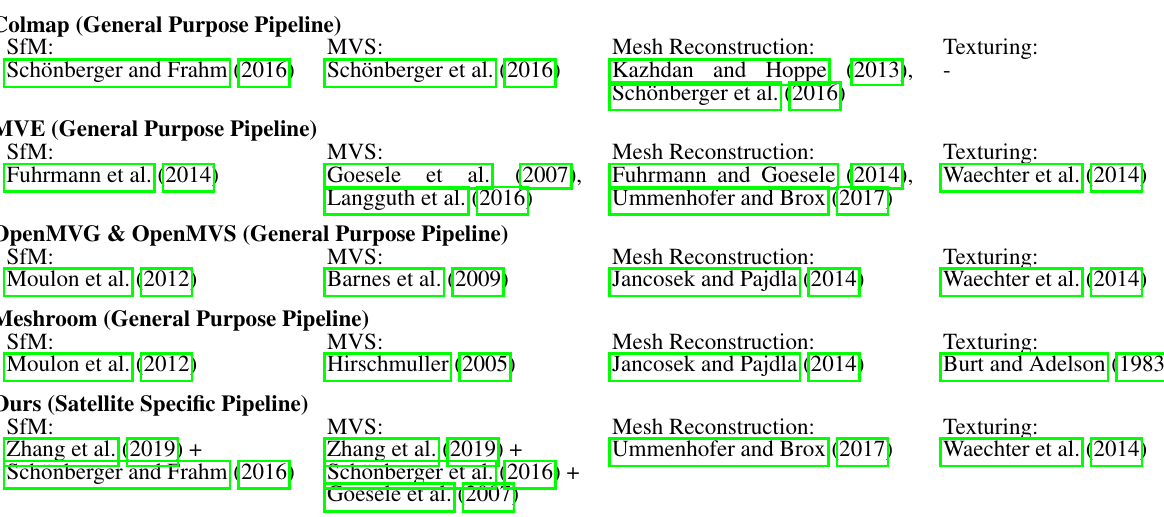
cover the actual depth